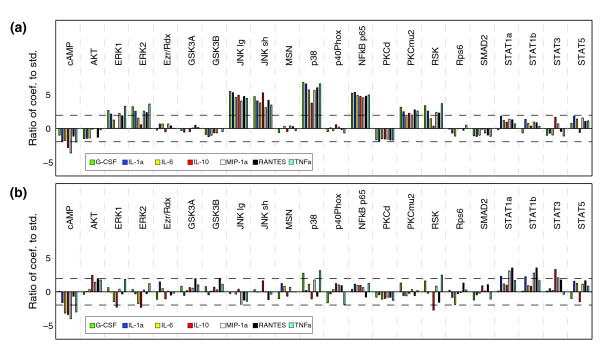
Significance of signaling-pathway predictors for cytokine release. Data from TLR ligand stimulation were (a) included or (b) excluded. PCR analyses were performed as described in Materials and methods. For a given output, significance of signaling responses was measured as the ratio of their regression coefficients (coef.) divided by the standard deviation (std) of coefficients corresponding to random outputs from the same population as the actual outputs (see Materials and methods). Averaged ratios outside a 95% confidence interval (horizontal dashed lines) are considered significant.